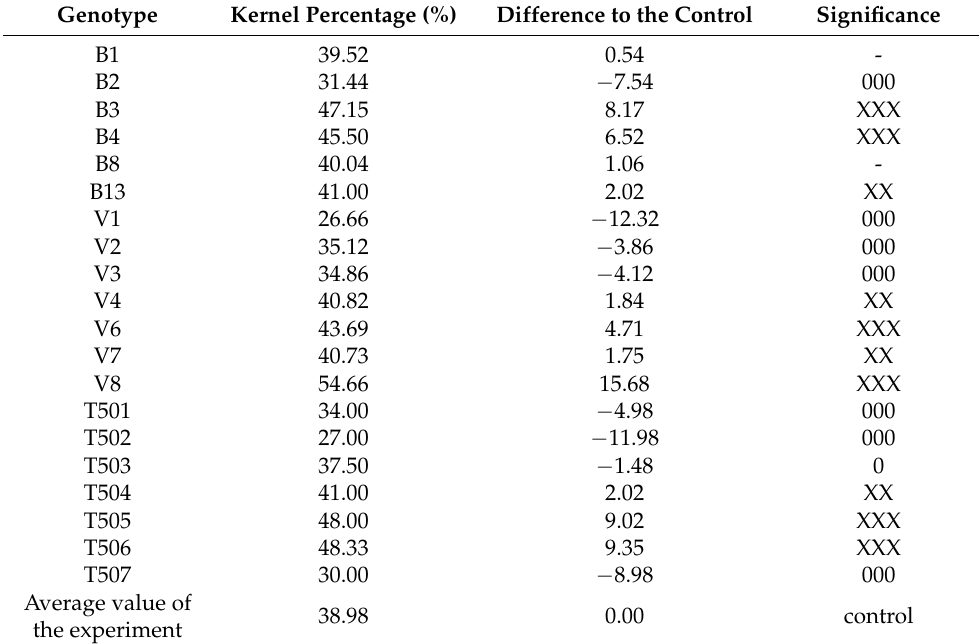
Table 2. Kernel percentage of different genotype from west and north-west of